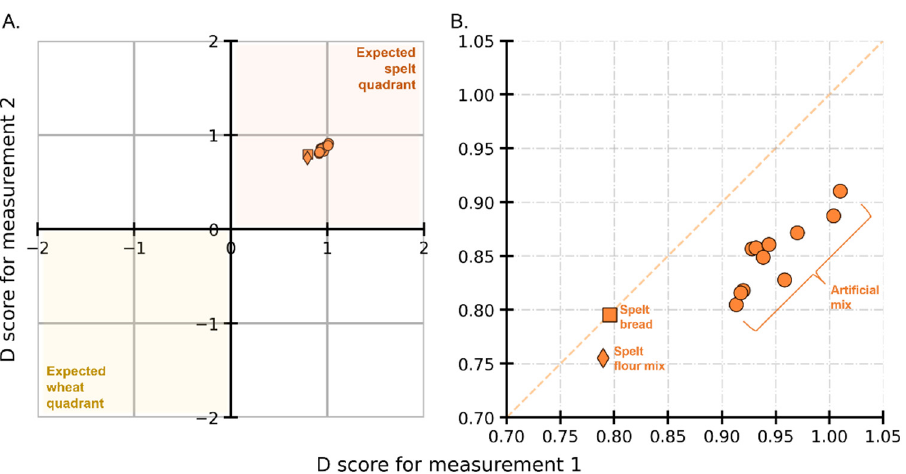
Figure 3. Youden plot showing the D scores for processed goods and artificial mix in the external validation set in ( A ) and a magnified section in ( B ). Spelt bread (orange square), spelt flour mix (orange diamonds), and artificial spectral mix (orange circles) are shown to be correctly predicted as spelt.